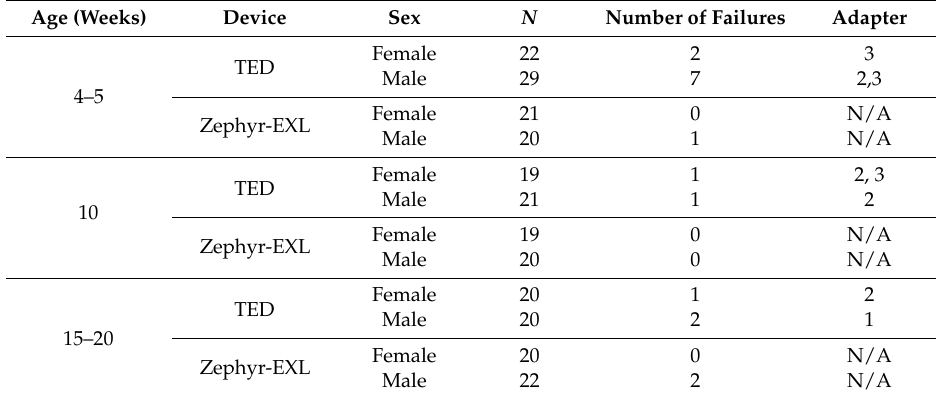
Table 4. Number of failures by device type, bird age, sex, and adapter selection.